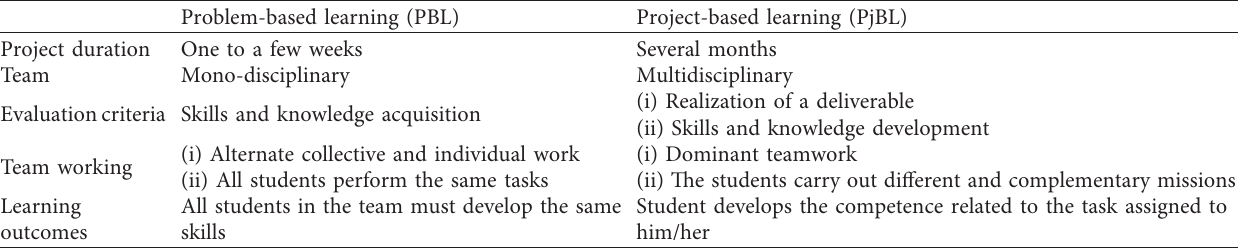
Table 1: Points of divergence between PBL and